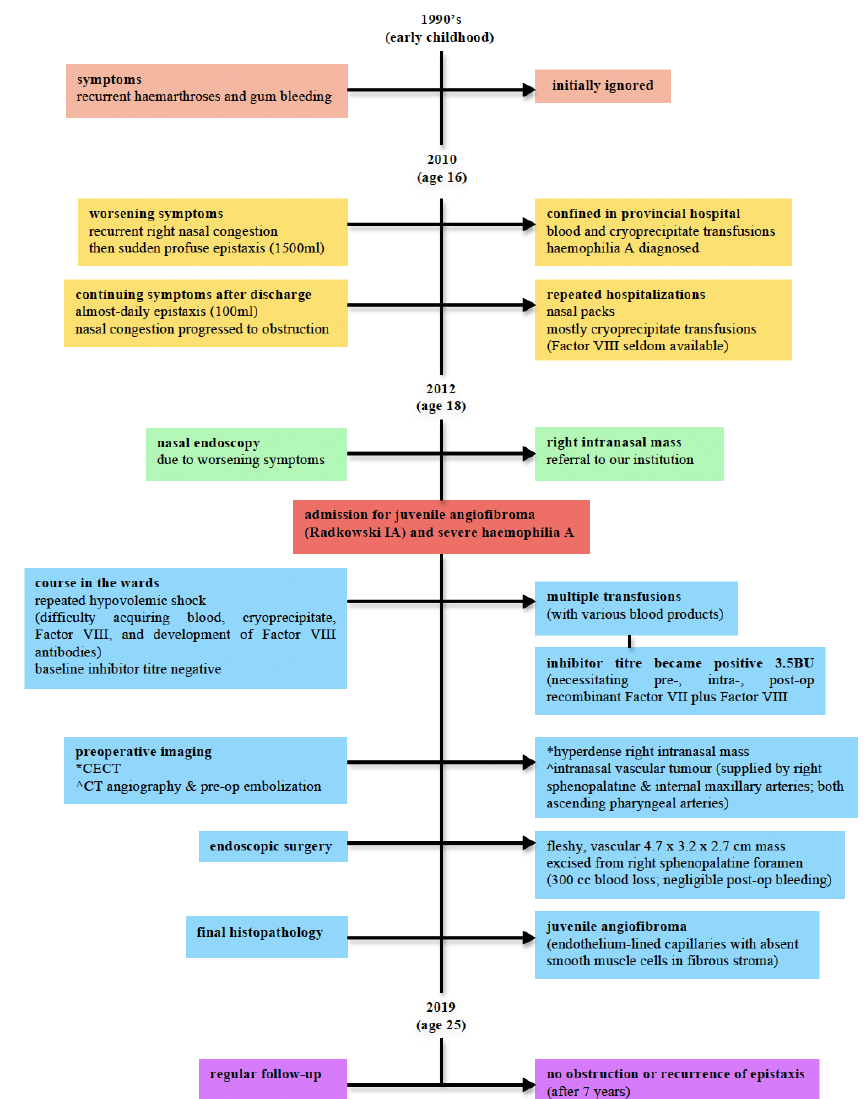
Figure 3. Timeline summarising important information from the case